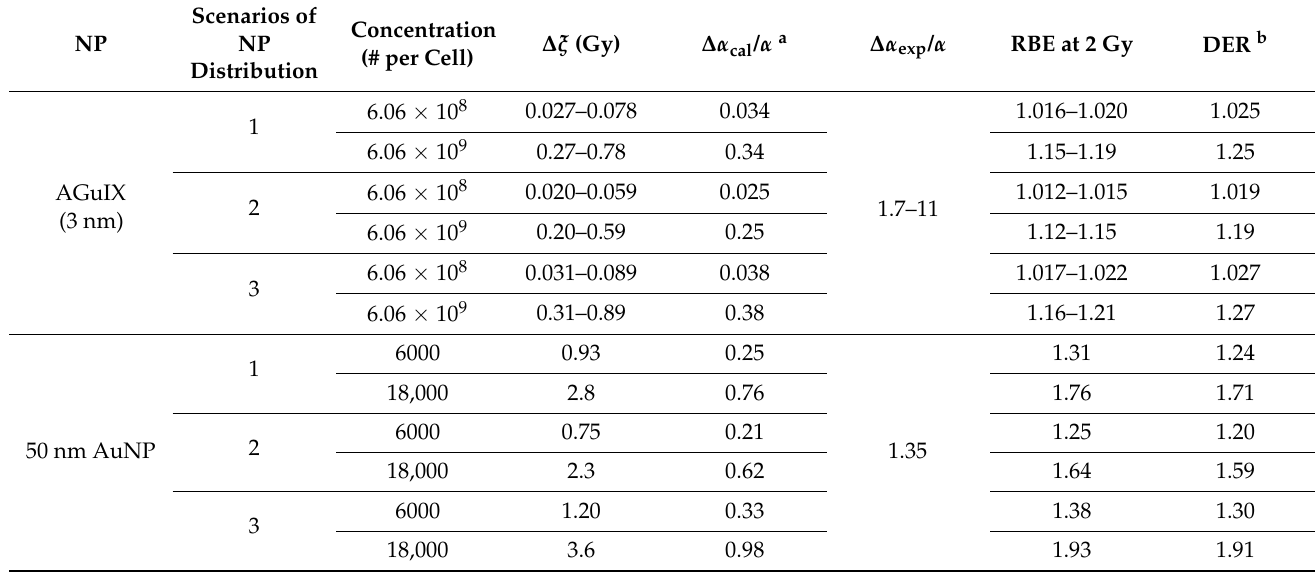
Table 2. Relative theoretical and measured increases in α , RBEs and DERs due to NPs for different scenarios of NP distribution in the cells at reported and hypothetical NP concentrations.